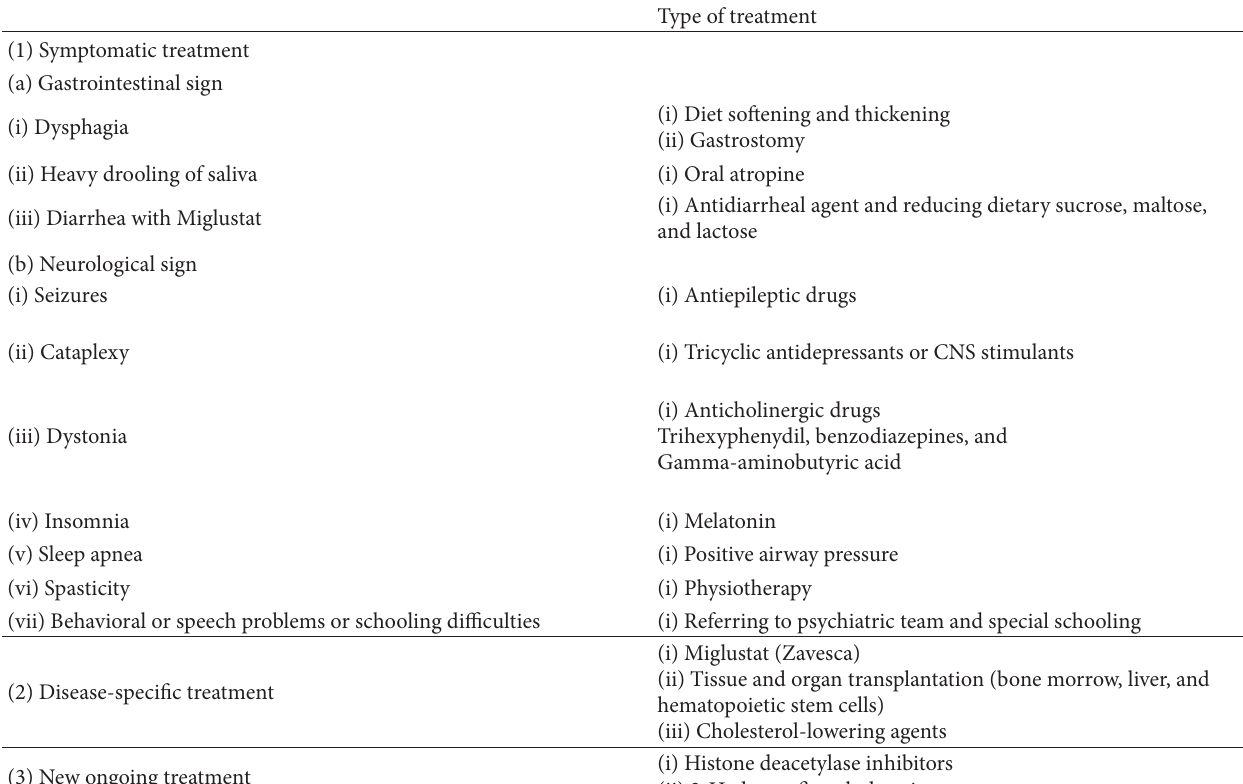
Table 5: Summary of treatment strategy in NP-C